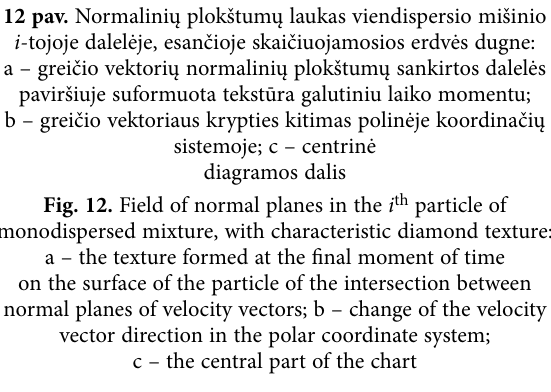
Fig. 12. Field of normal planes in the i th particle of monodispersed mixture, with characteristic diamond texture: a – the texture formed at the final moment of time on the surface of the particle of the intersection between normal planes of velocity vectors; b – change of the velocity vector direction in the polar coordinate system; c – the central part of the chart